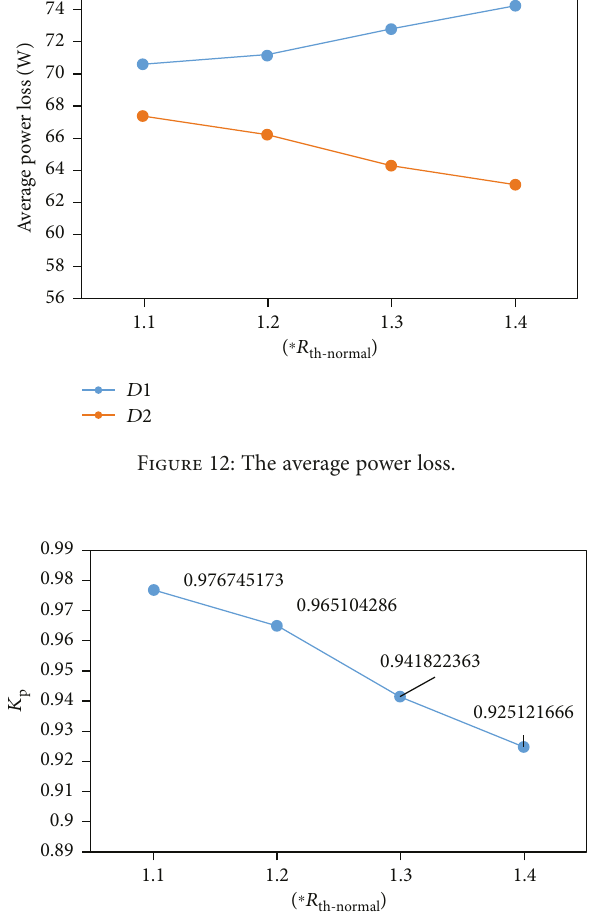
Figure 13: The coe ffi cient of power loss sharing between the D 1 and D 2 .